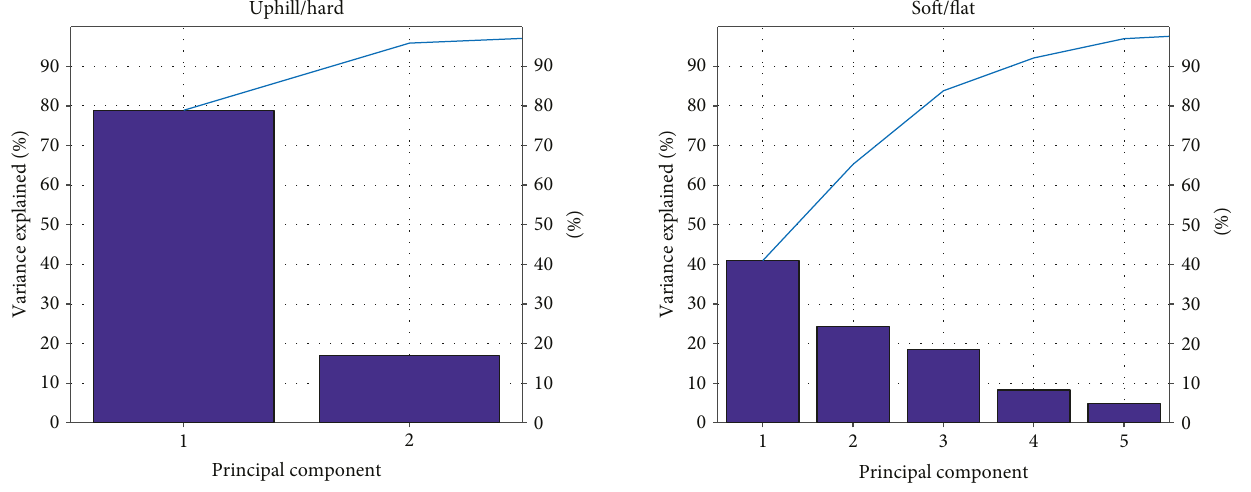
Figure 11: The relationship between the principal component and the variance explained for S/F.